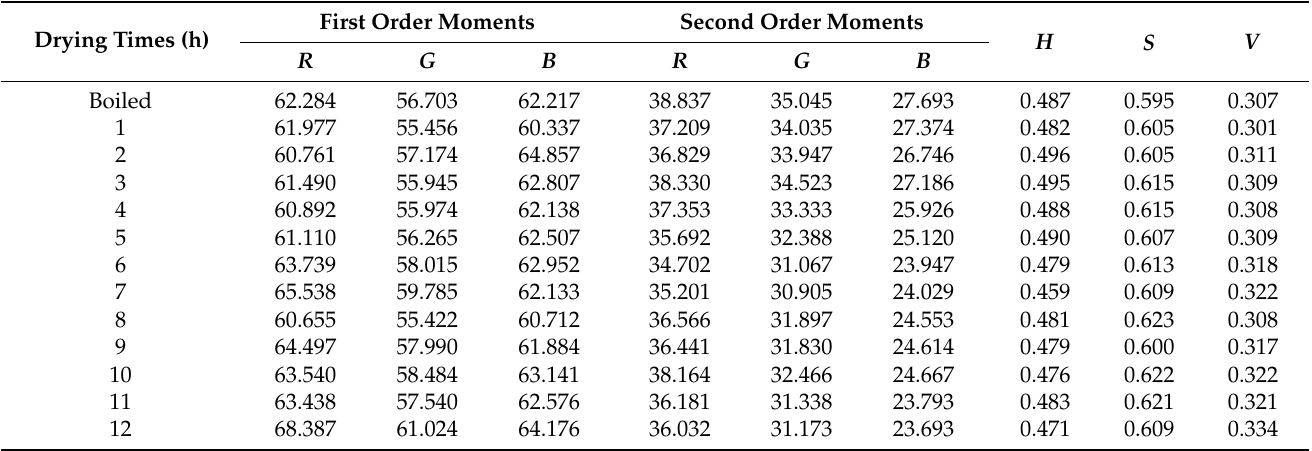
Figure 7. Comparison of CARS-PLSR and CARS-LSSVM in terms of ( a ) moisture content, ( b ) L *, ( c ) a *, ( d ) b *, ( e ) hardness, and ( f ) elasticity based on quantitative analysis models in shrimp during drying. Table 4. Extracted image feature information of